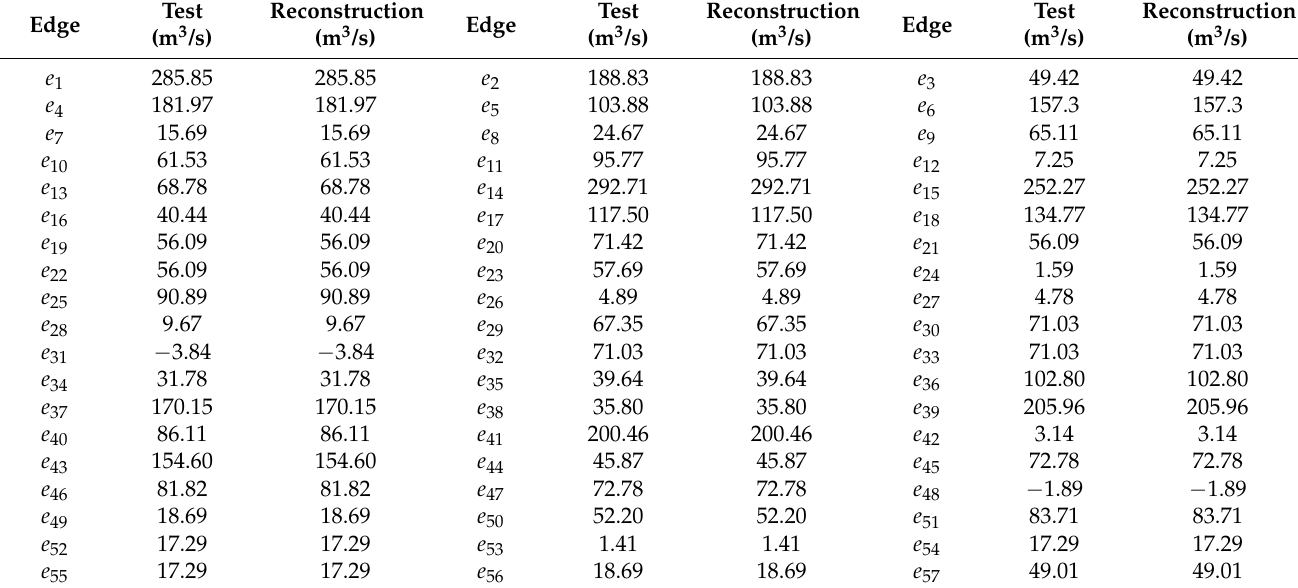
Figure 8. Coal mine ventilation used by Jinmei Co., Ltd. The magenta represents spanning trees and the blue represents cotrees.